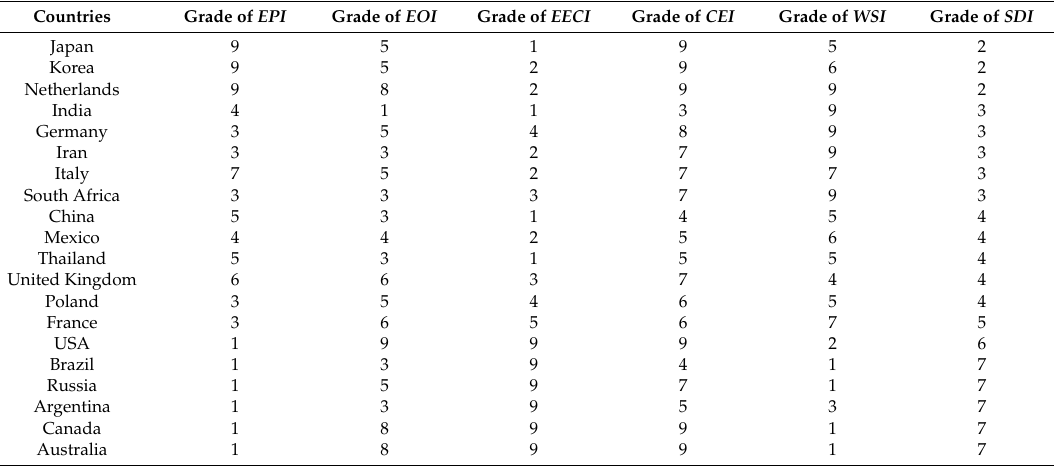
Table 2. The sustainability assessment results for different